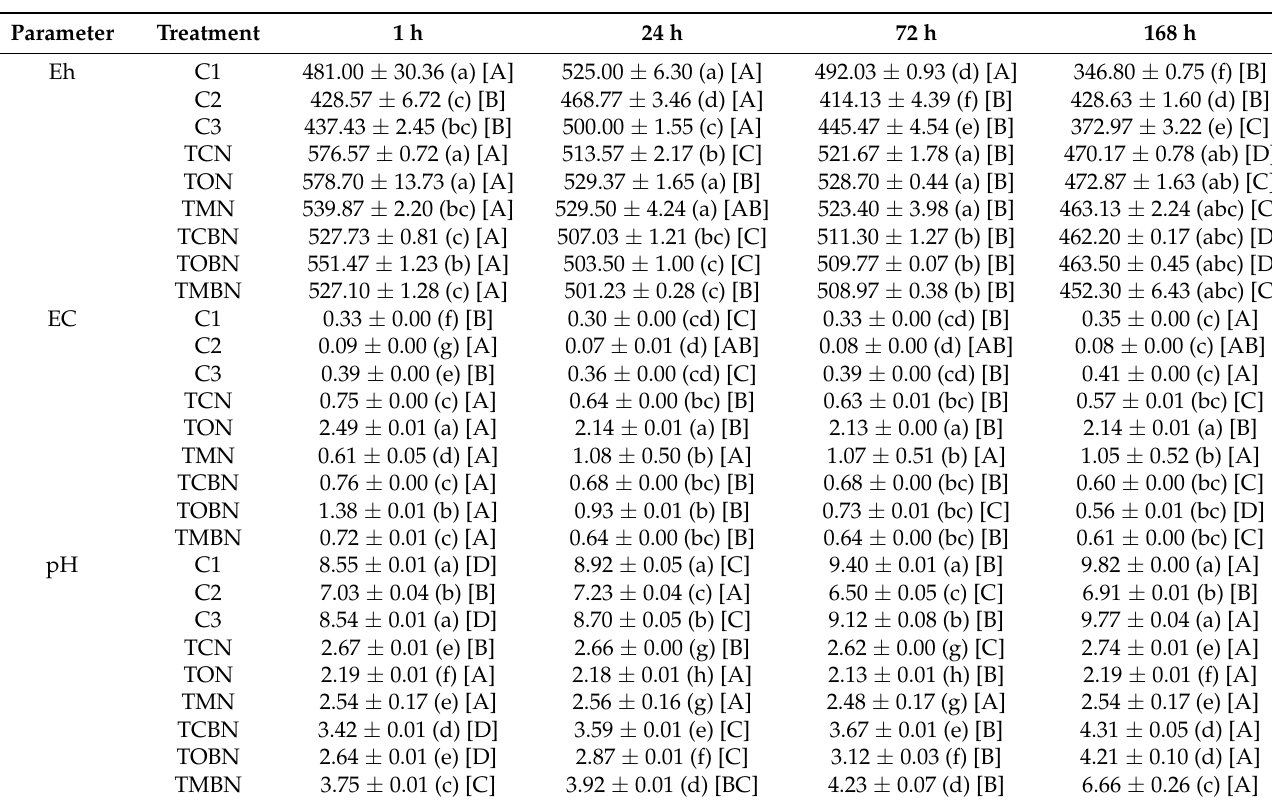
Table 1. Eh, EC, and pH measured at different times during the experiment for the controls and treat-